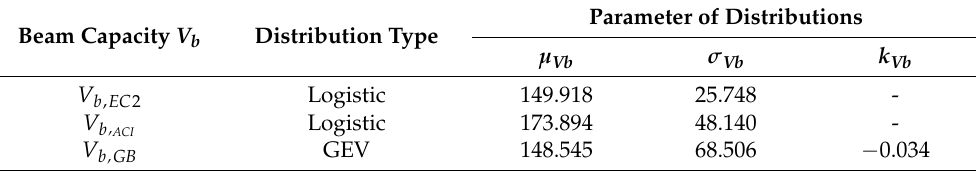
Figure 5. Distribution fitting of the beam capacity V b . Table 5. Parameter estimation for the distributions of beam capacity V b .